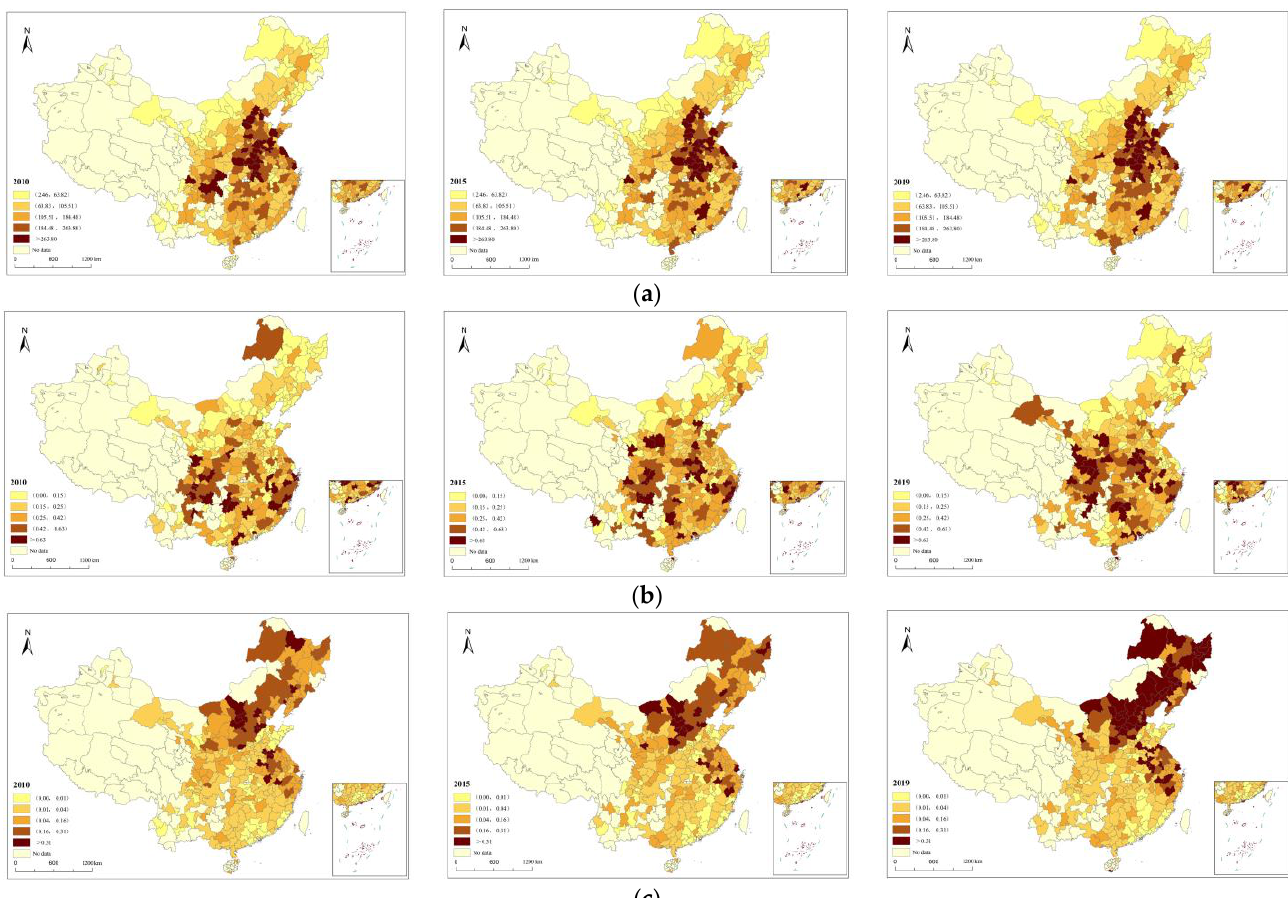
Figure 2. Spatiotemporal distribution of the borrowing size. ( a ) Spatiotemporal distribution of the borrowing population size. ( b ) Spatiotemporal distribution of the borrowing economic activity density. ( c ) Spatiotemporal distribution of the borrowing economic activity density.